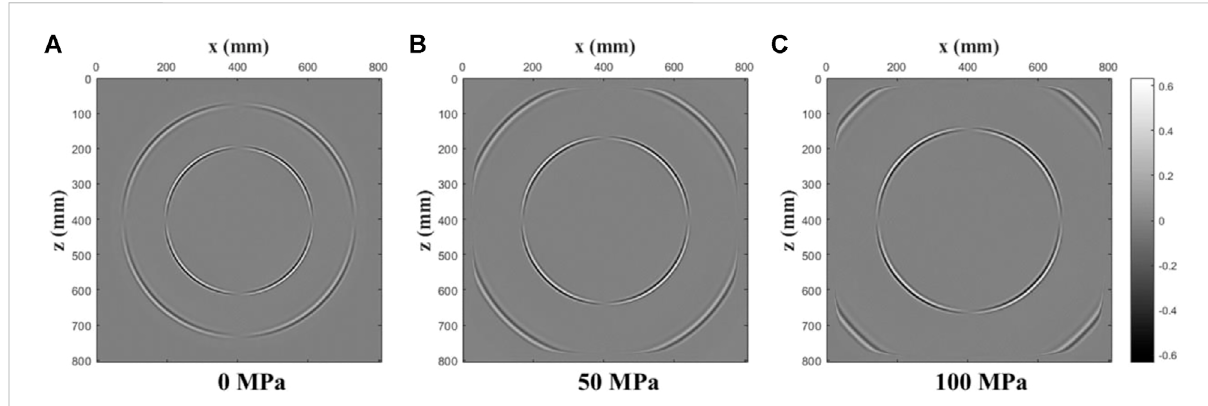
FIGURE 2 Coupled wave fi eld snapshots of the x -component of the particle velocity at t = 0.1 ms for various con fi ning stresses. ( (A) : 0 MPa; (B) : 50 MPa; (C) : 100 MPa)